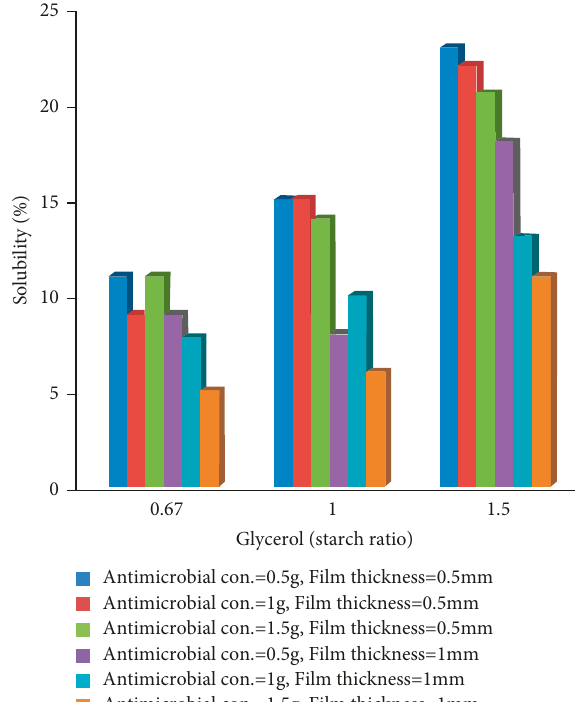
Figure 5: Solubility of packaging film at different glycerol/starch ratios.